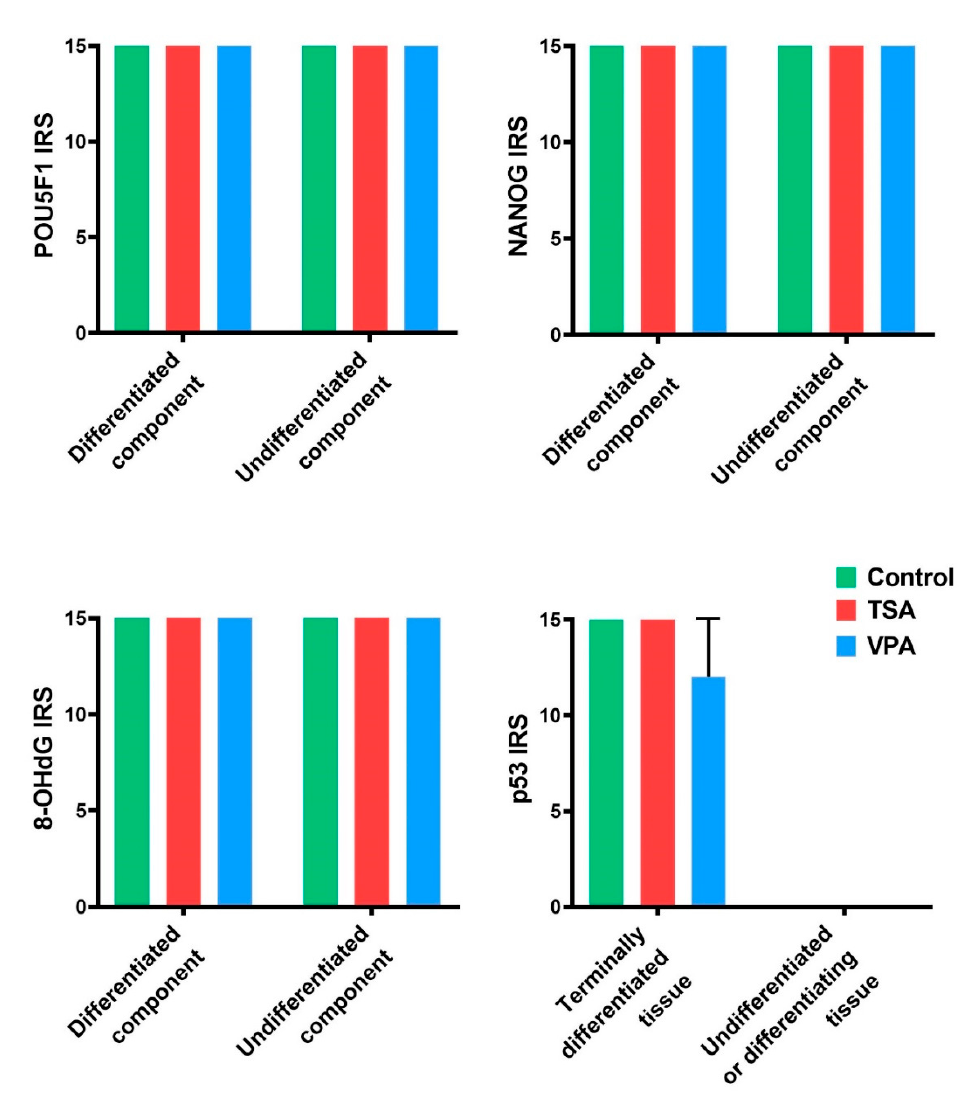
Figure 7. IHC analysis of in vitro treated teratomas, separated by tissue component. Values represented are means with 95% CI.